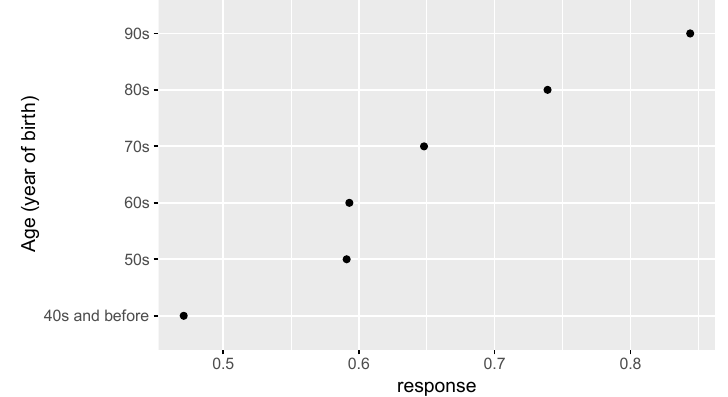
Figure 2. Zero-inflated regression coefficient of age. Figure 1. Zero-inflated regression coefficient of